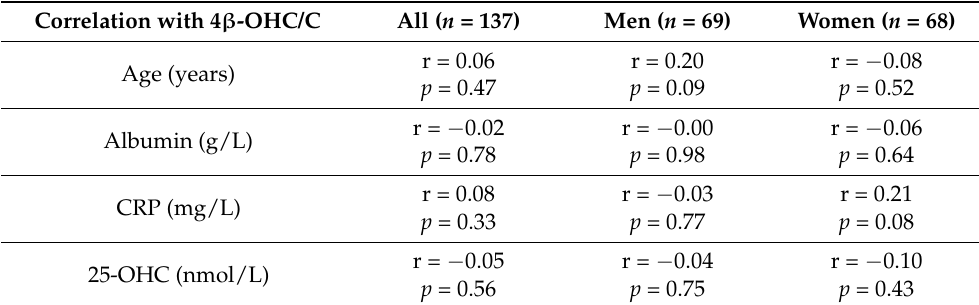
Table 3. The correlation coefficient r (Spearman’s rank test) between 4 β -hydroxycholesterol/cholesterol ratio (4 β -OHC/C) and the different variables measured in the study. p < 0.05 is considered as statistically significant .